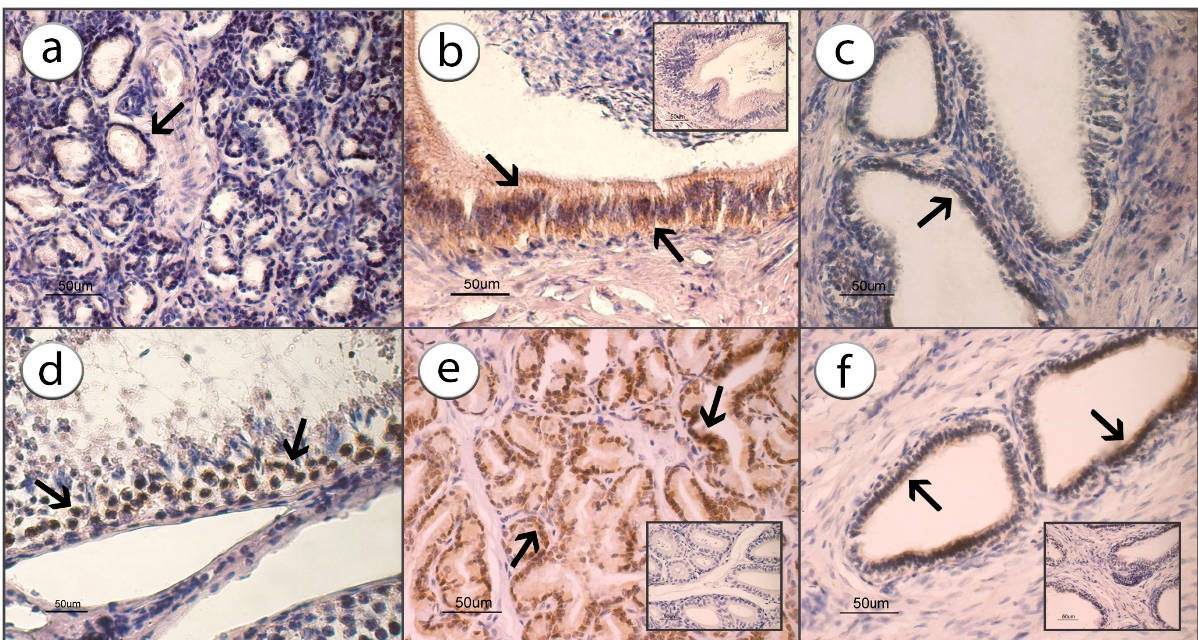
Figure 1. Immunostaining for ADIPOR1 in bulbourethral gland ( a ), epididymis ( b ), seminal vesicle ( c ), testicle ( d ), prostate ( e ) and vas deferens ( f ) counterstained with hematoxylin. The arrows indicate the positive localization of the immunoreaction, while the inserts in ( b , e , f ) are examples of the negative reactions.